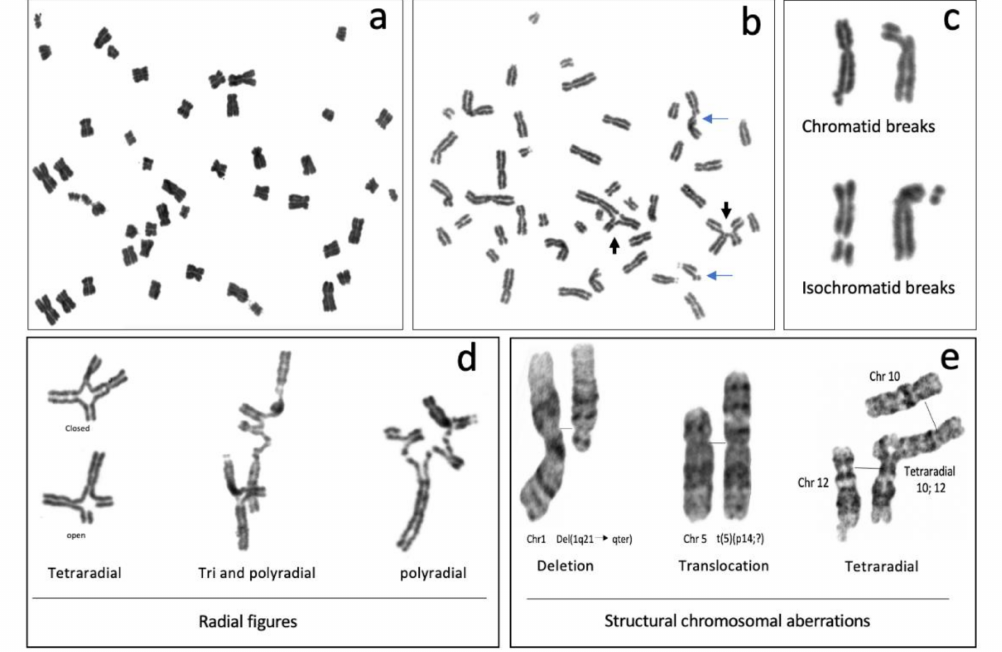
Figure 3. Representative metaphases and common structural chromosome aberrations observed in FA cells cultured with 0.1 µ g / mL DEB: ( a – d ) peripheral blood lymphocytes from a patient with FA and ( e ) from a patient derived, FANCA mutated VU817 lymphoblastoid cell line. ( a ) Endoreduplication. ( b ) Metaphase with structural chromosomal aberrations; blue arrows show chromatid breaks and black arrows show radial figures. ( c ) Breaks. The images show how the broken fragments are kept very close to the chromosome that originated them because there is a cohesion of chromatids in metaphase. ( d ) Radial figures. In the first column can be observed that the tetraradial can be closed when the four DNA ends of the two non-homologous chromosomes are rejoined or open when only two of the four DNA ends were rejoined. ( e ) GTG banded chromosomes reveal other gross structural chromosomal aberrations that may be found in FA cells, such as deletions and translocations. In the radial figure, normal chromosomes 10 and 12 are aligned with the tetraradial, to highlight the trajectory of the